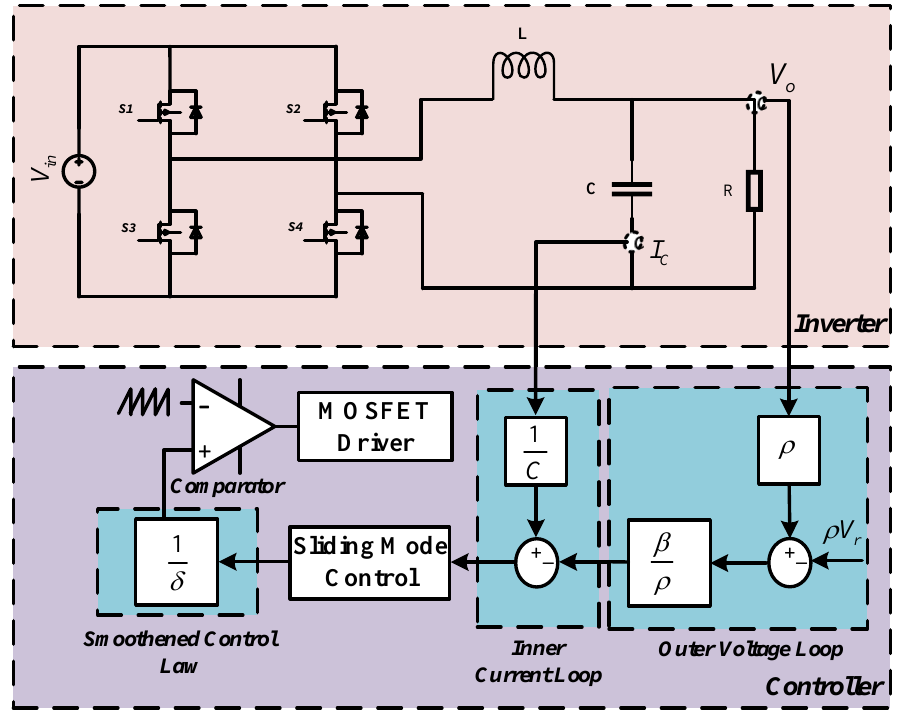
Figure 2. Block diagram representation of PWM-based hysteresis sliding mode